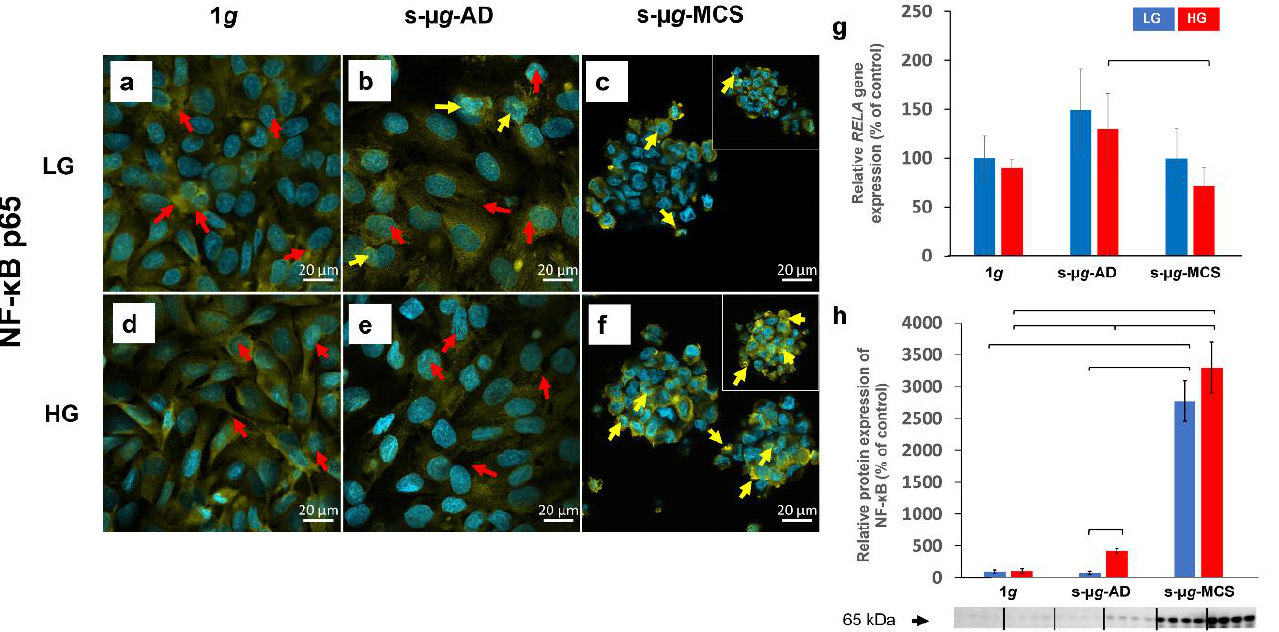
Figure 9. Analysis of NF- κB p65 after 14 days of cultivation either at 1 g or on the clinostat, either using low (LG) or high (HG) glucose medium. Data were obtained via immunostaining ( a – f ), qPCR ( g ), and Western blot ( h ). The brackets stand for a significance level of p < 0.05.